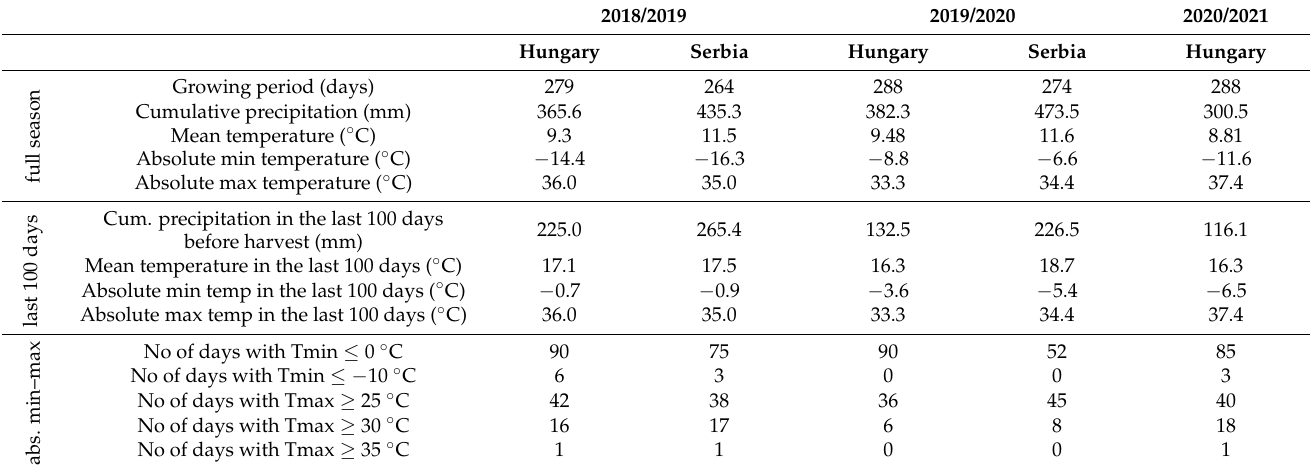
Table 3. Meteorological conditions for the three growing seasons in Hungary and two growing seasons in